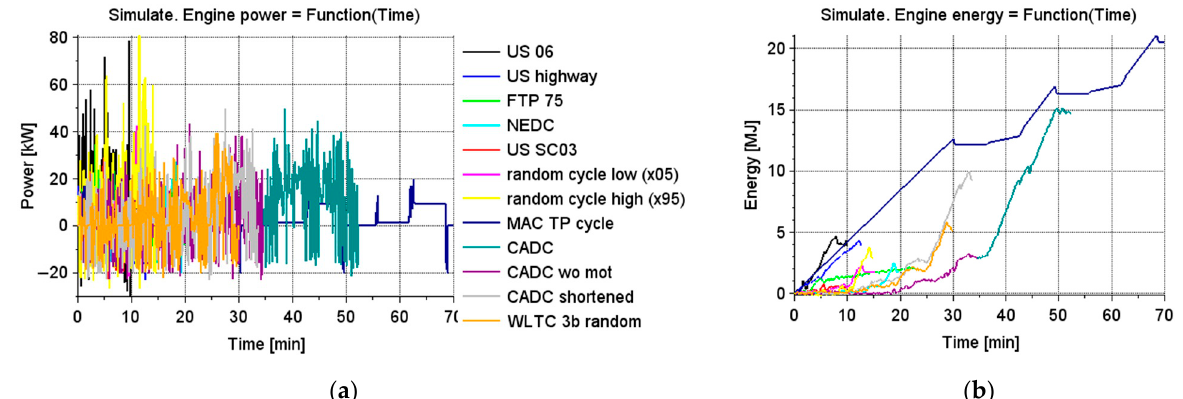
Figure 9. Results obtained in the simulation of selected road tests for the Toyota Camry LE 2018 vehicle: ( a ) waveforms of the instantaneous values of power generated by the engine; ( b ) waveforms of the instantaneous values of mechanical energy generated by the vehicle engine.